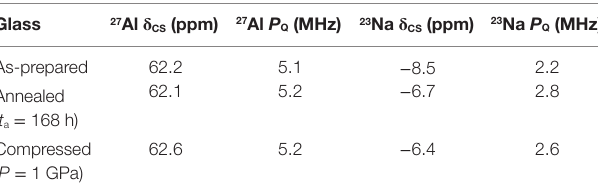
TaBle 1 | isotropic chemical shift ( δ cs ) and quadrupolar coupling constant ( P Q ) derived from the 3QMas nMr data of the as-prepared glass and the glasses compressed at 650°c at 1 gPa or annealed at 0.92 T g for 168 h. glass